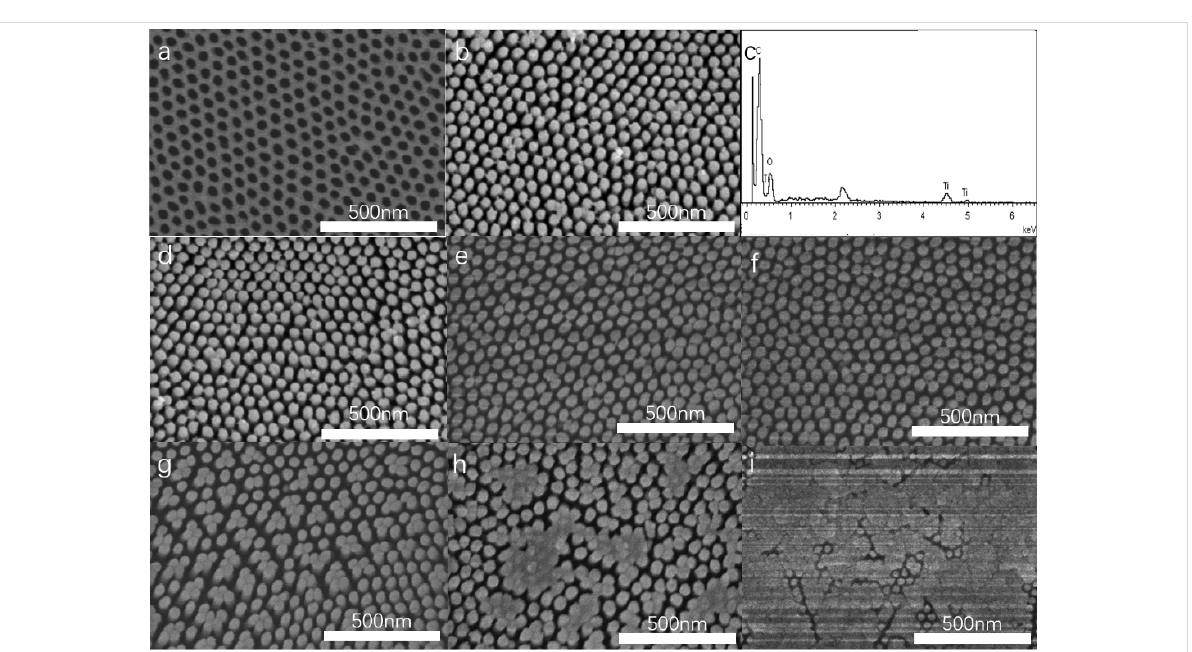
Figure 2: SEM images of the top view of different samples: (a) AAO template, (b) TNC, (c) EDS of TNC, (d) AFT1, (e) AFT2, (f) AFT3, (g) ACT1, (h) ACT2, and (i) ACT3.